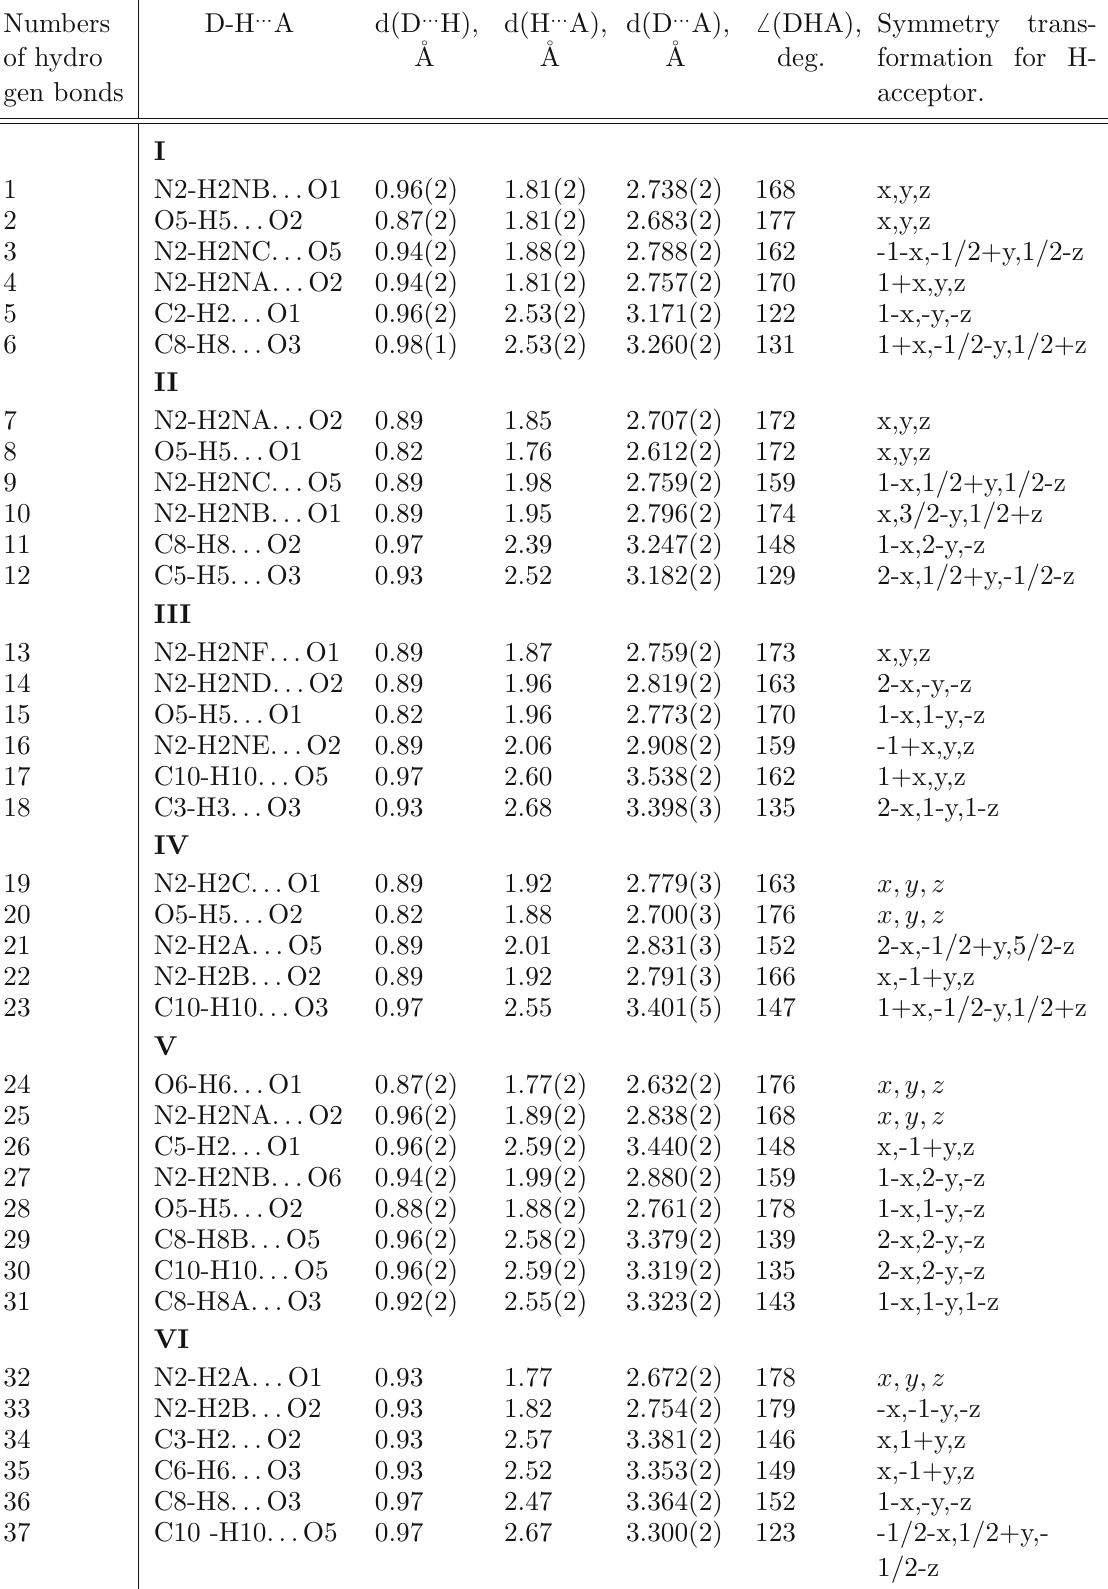
Table 2 Hydrogen bonds in X-ray structures I – VI